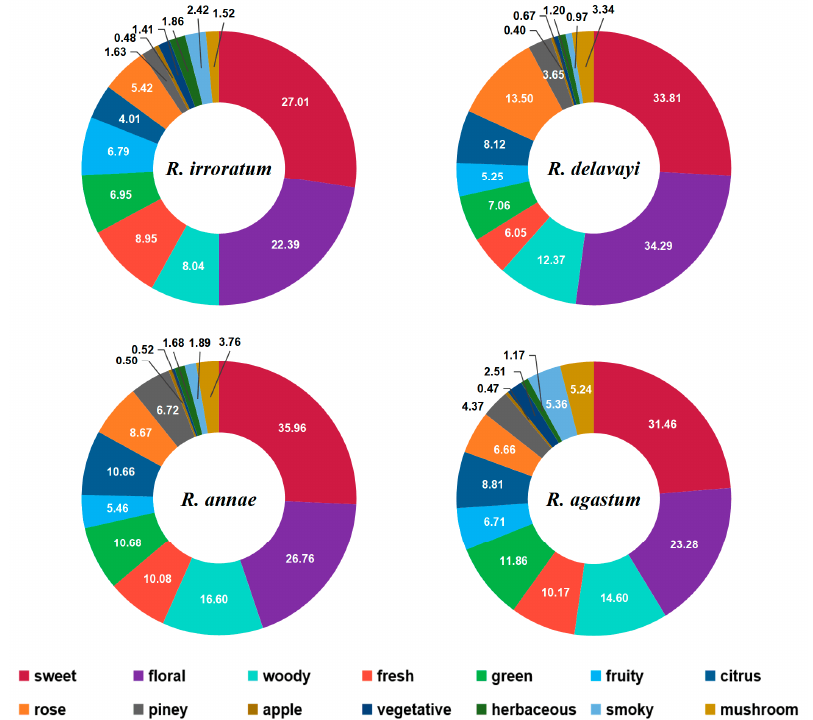
Figure 5. Proportions of odor compounds in Rhododendron .